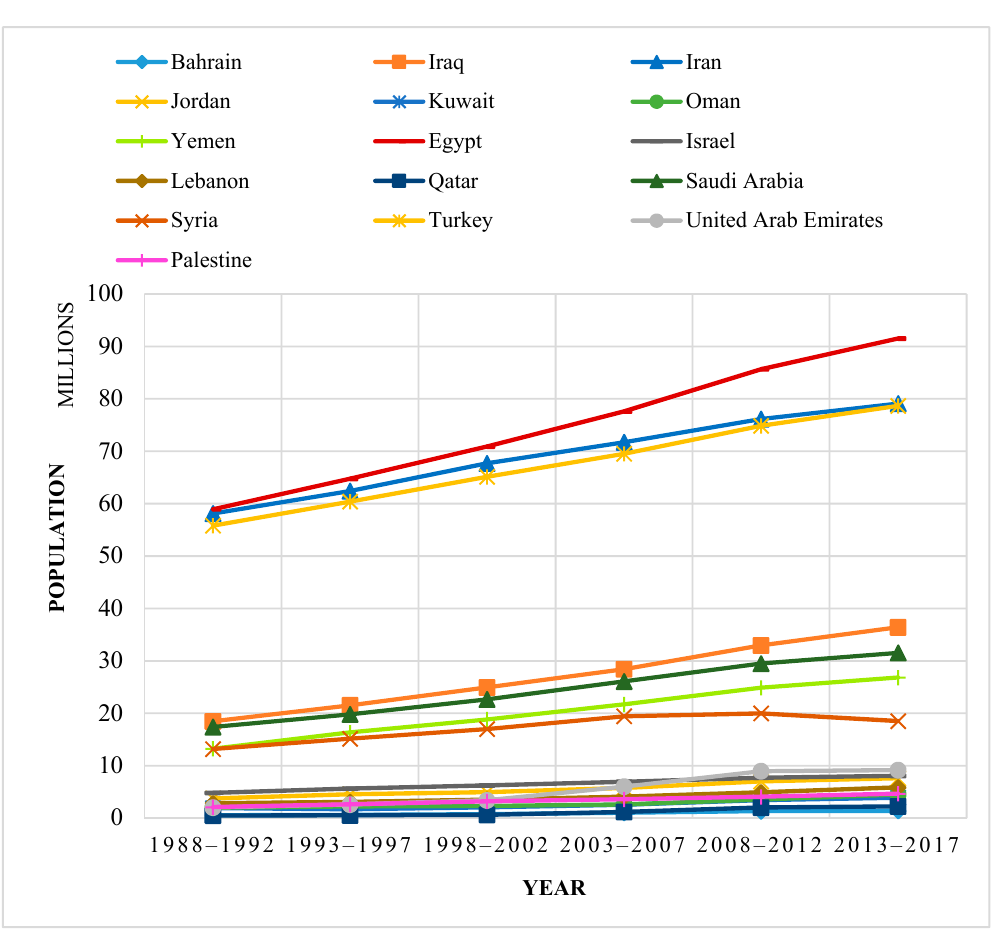
Figure 9. Five-year average population of each country in the Middle East. Source: FAO-AQUASTAT Database and Worldometers. The data is acquired from: www.Worldometers.info.